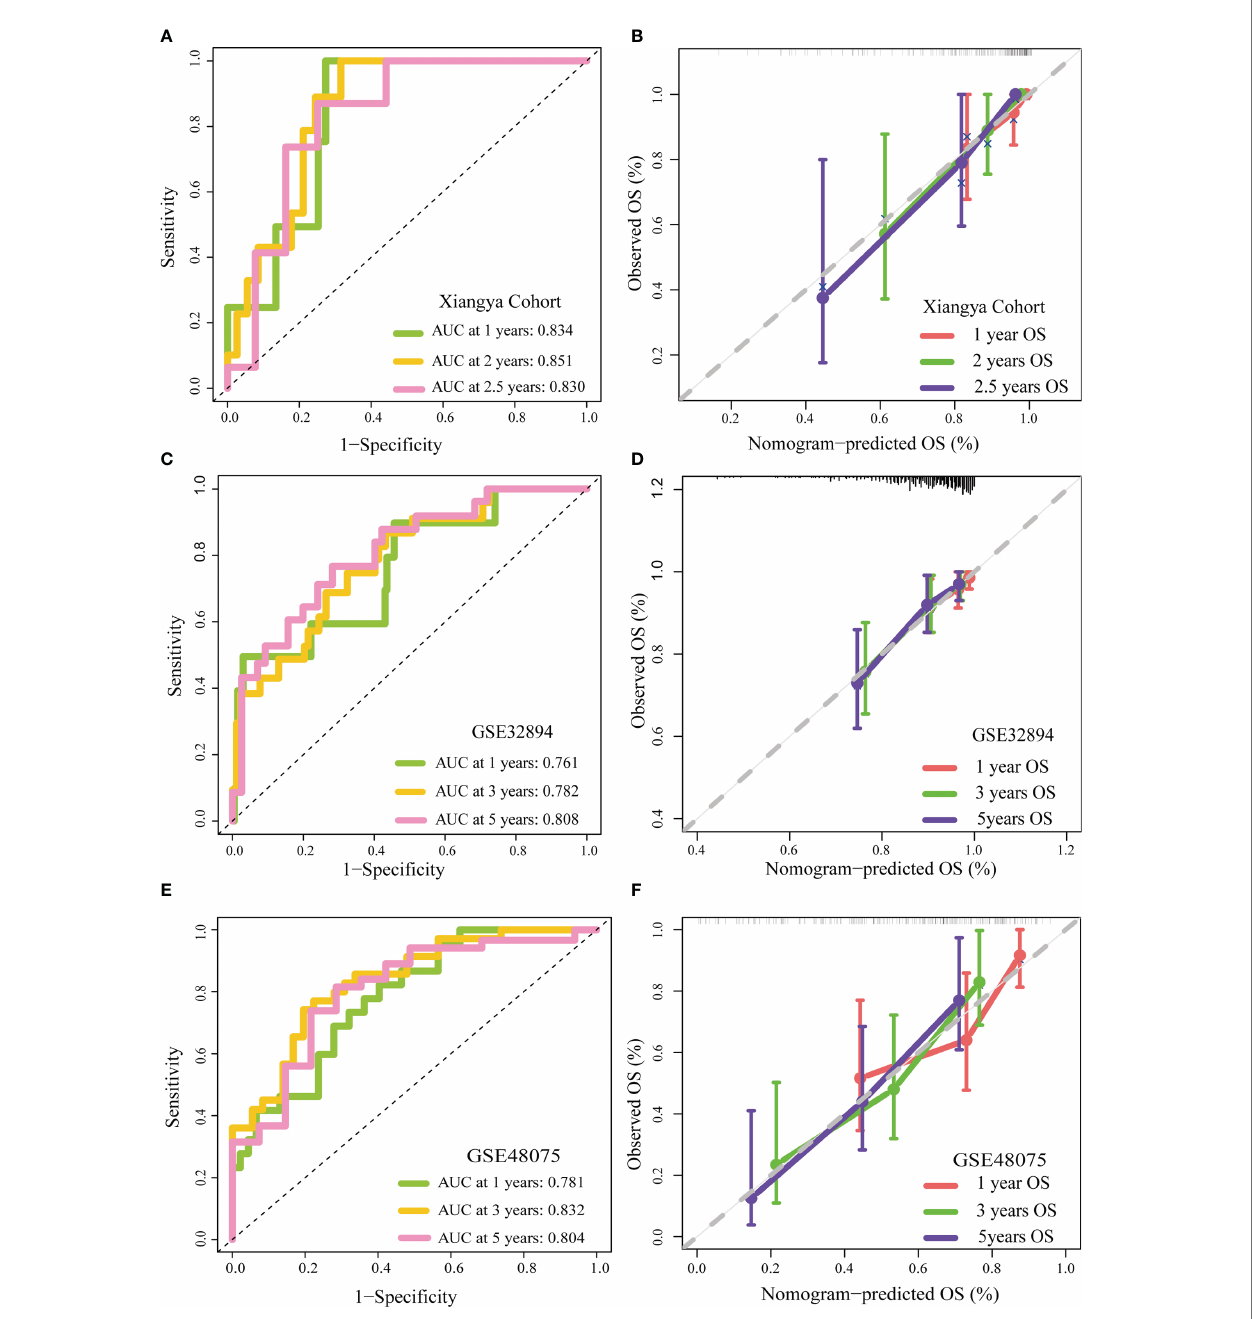
FIGURE 3 | External validation of the TGF- b risk score. (A, B) Role of the TGF- b risk score in the Xiangya cohort. (C, D) Role of the TGF- b risk score in GSE32894. (E, F) Role of the TGF- b risk score in